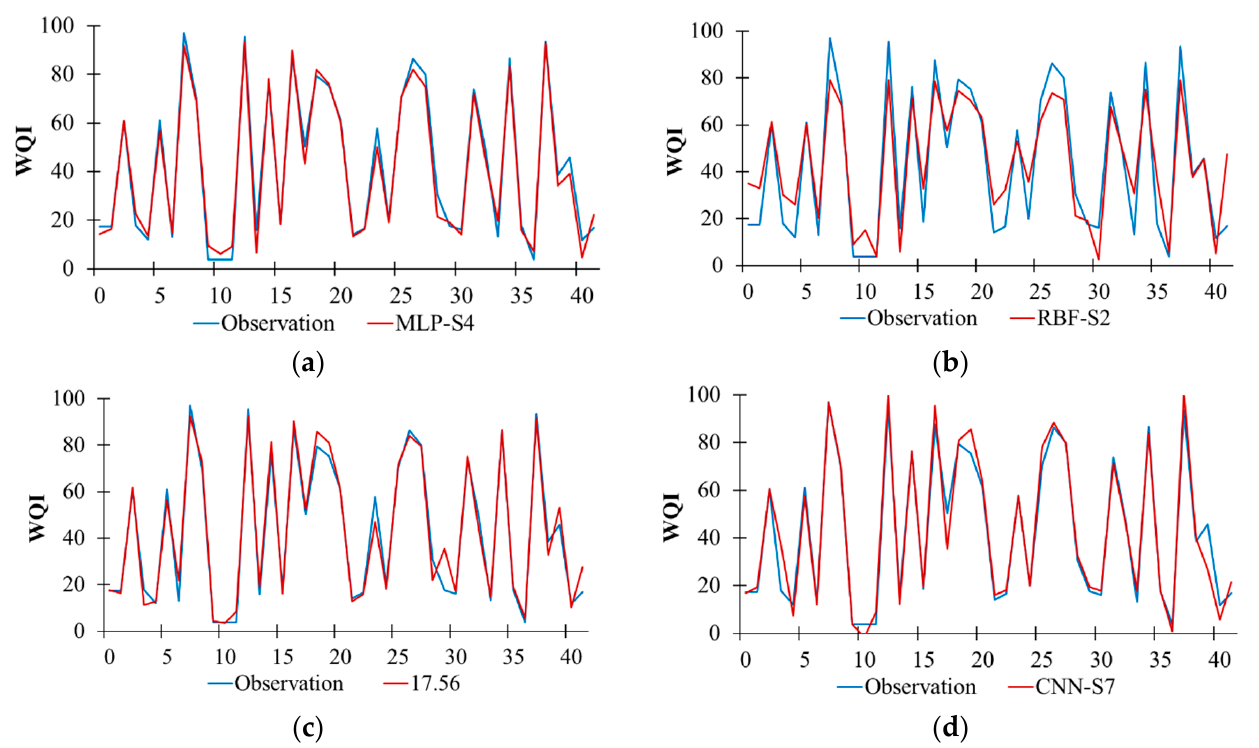
Figure 4. Temporal variation in the observed and predicted WQI values for the best performance models using ANN-based algorithms during the testing period. ( a ) MLP-S4. ( b ) RBF-S2. ( c ) DFNN-S2. ( d ) CNN-S7.